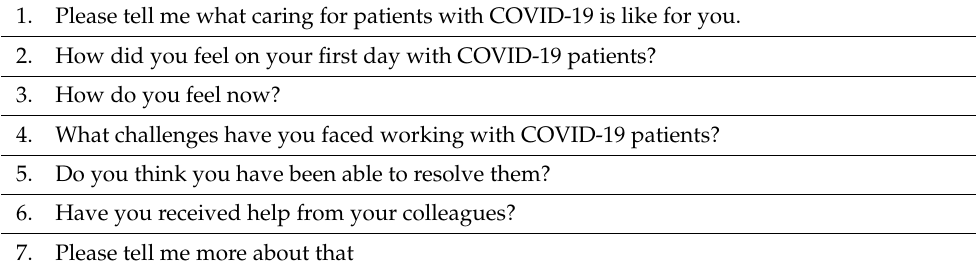
Table 1. Interview